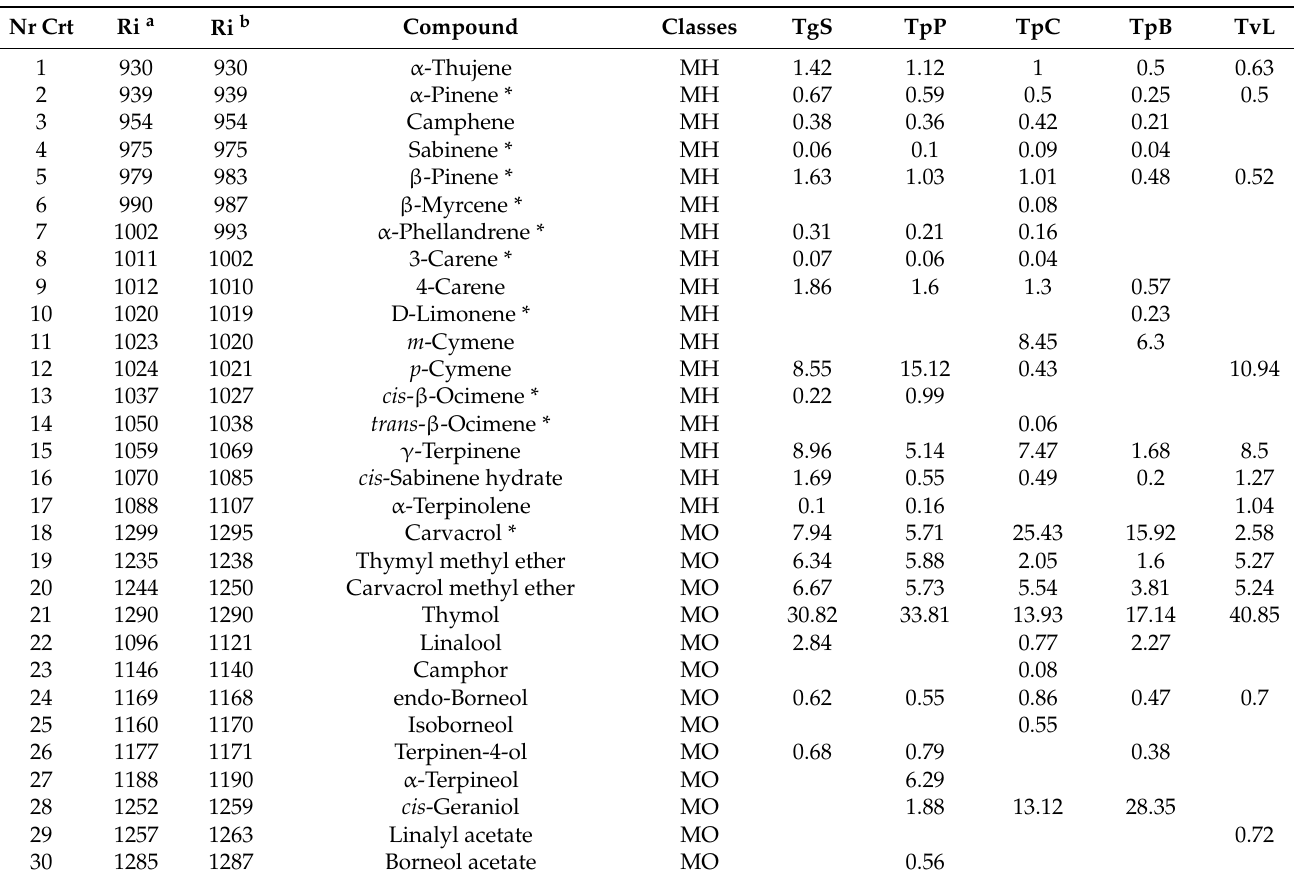
Figure 1. Chromatograms obtained for the EOs extracted from each thyme population: T. odoratissimus (TgS)—black; T. pulegioides (TpP)—pink; T. pulegioides (TpC)—blue; T. pulegioides (TpB)—red; T. vulgaris (TvL)—green. Table 2. Chemical composition of the EOs isolated from aerial part of the Thymus population collected from five areas in Banat: T. odoratissimus (TgS); T. pulegioides (TpP); T. pulegioides (TpC); T. pulegioides (TpB); T. vulgaris (TvL).